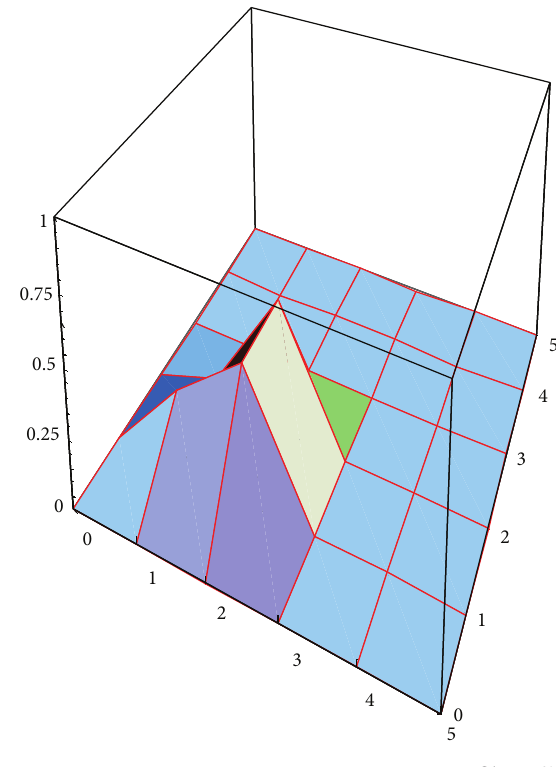
Figure 19: Demonic union of fuzzy relations